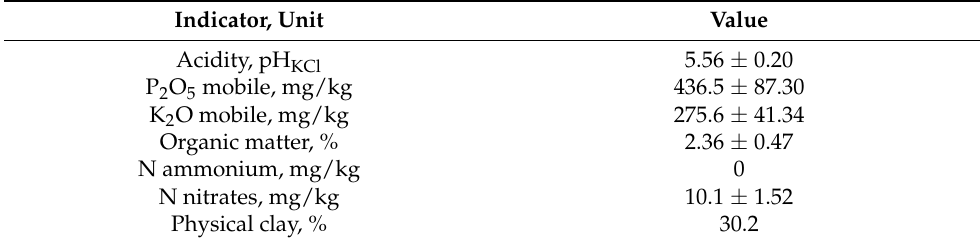
Table 1. Agrochemical soil